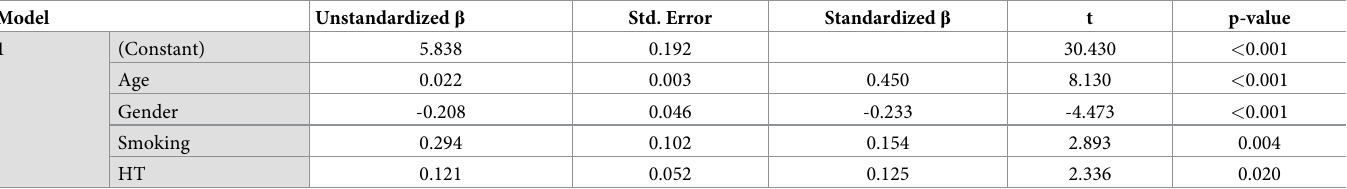
Table 3. Multiple linear regression model with lnGDF-15 as dependent